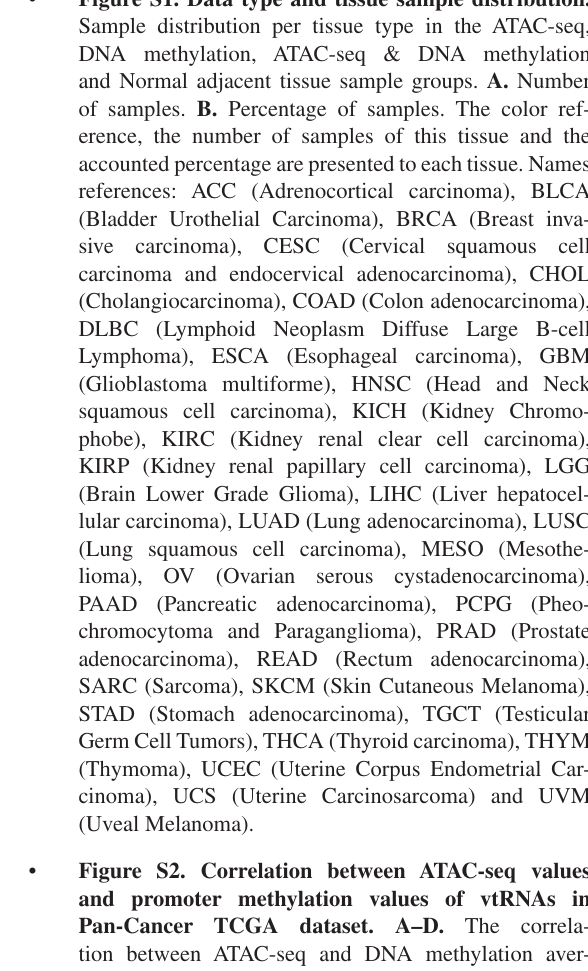
Figure S2. Correlation between ATAC-seq values and promoter methylation values of vtRNAs in Pan-Cancer TCGA dataset. A–D. The